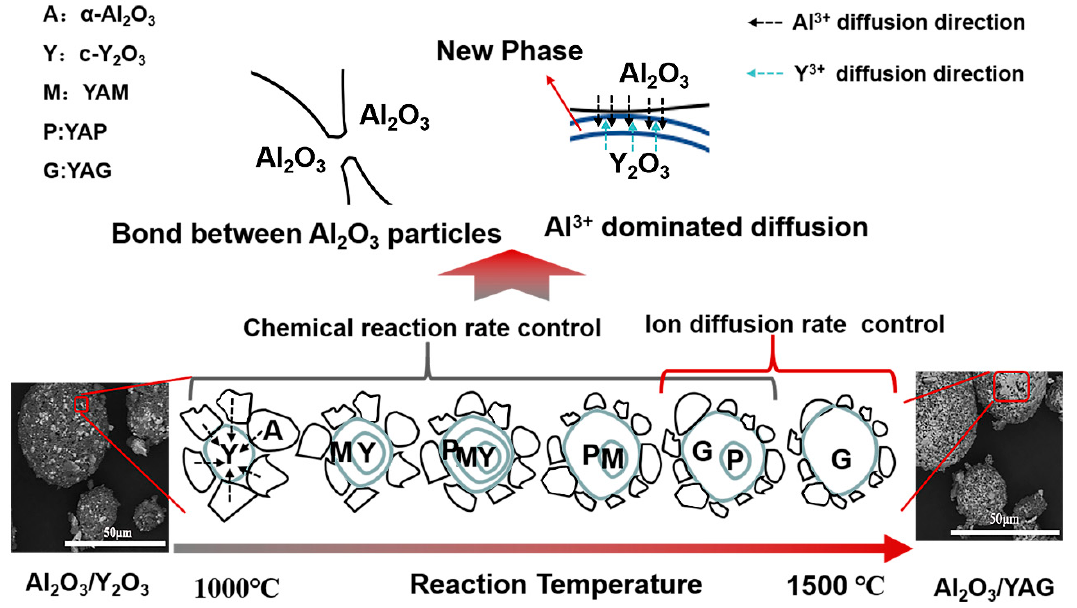
Figure 7. Schematic illustration of solid-state reaction process of Al 2 O 3 –Y 2 O 3 system.